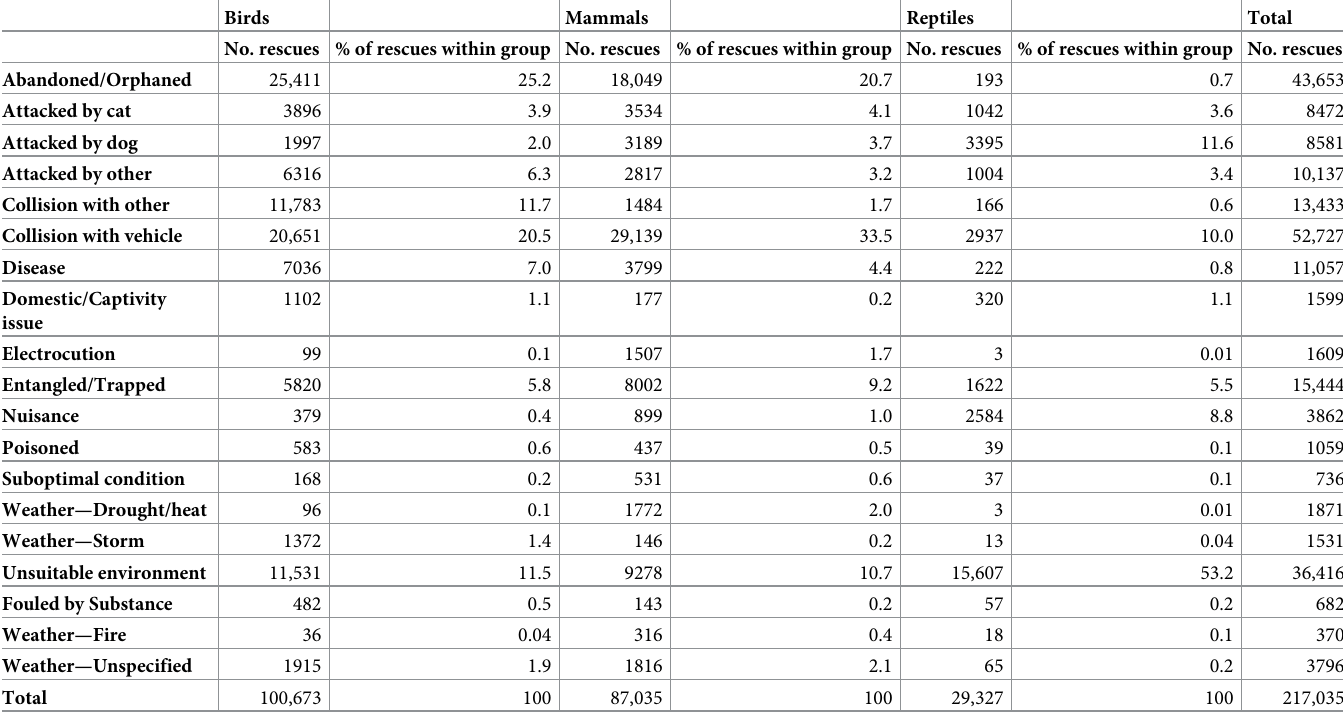
Table 7. Number of records for each animal group and for each cause for rescue, and percent (%) of rescues within each group attributed to each cause for rescue. Birds Mammals Reptiles